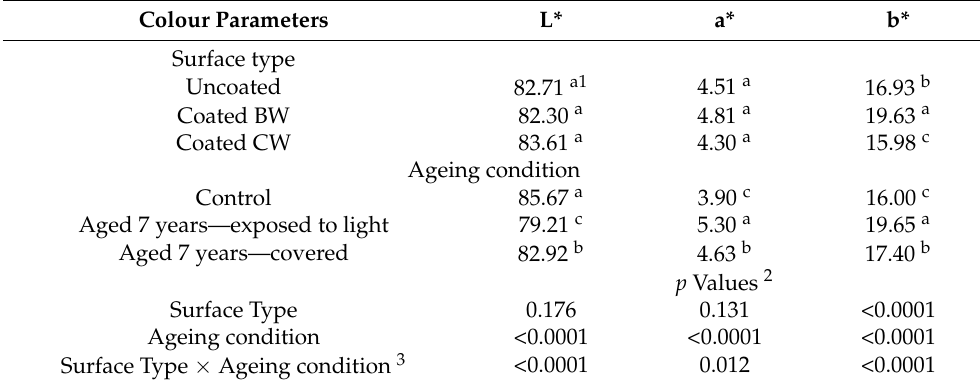
Table 2. Results of the two-way ANOVA statistical analysis of colour data for the uncoated and wax coated (BW, CW) samples of European maple, before and after 7 years of indoor